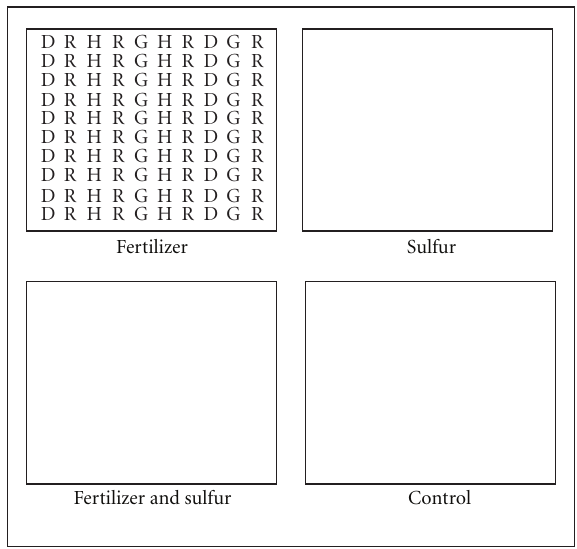
Figure 1: Block layout: three replicate blocks located at seven sites in Western Oregon were employed for the field experiment. Four treatment plots (whole plot) contained four species (split-plot) of conifers planted in rows of ten seedlings (D: Douglas-fir; G: grand fir; H: western hemlock; R: western redcedar).